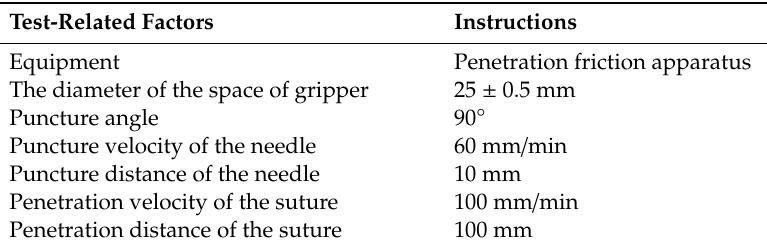
Table 1. Experimental